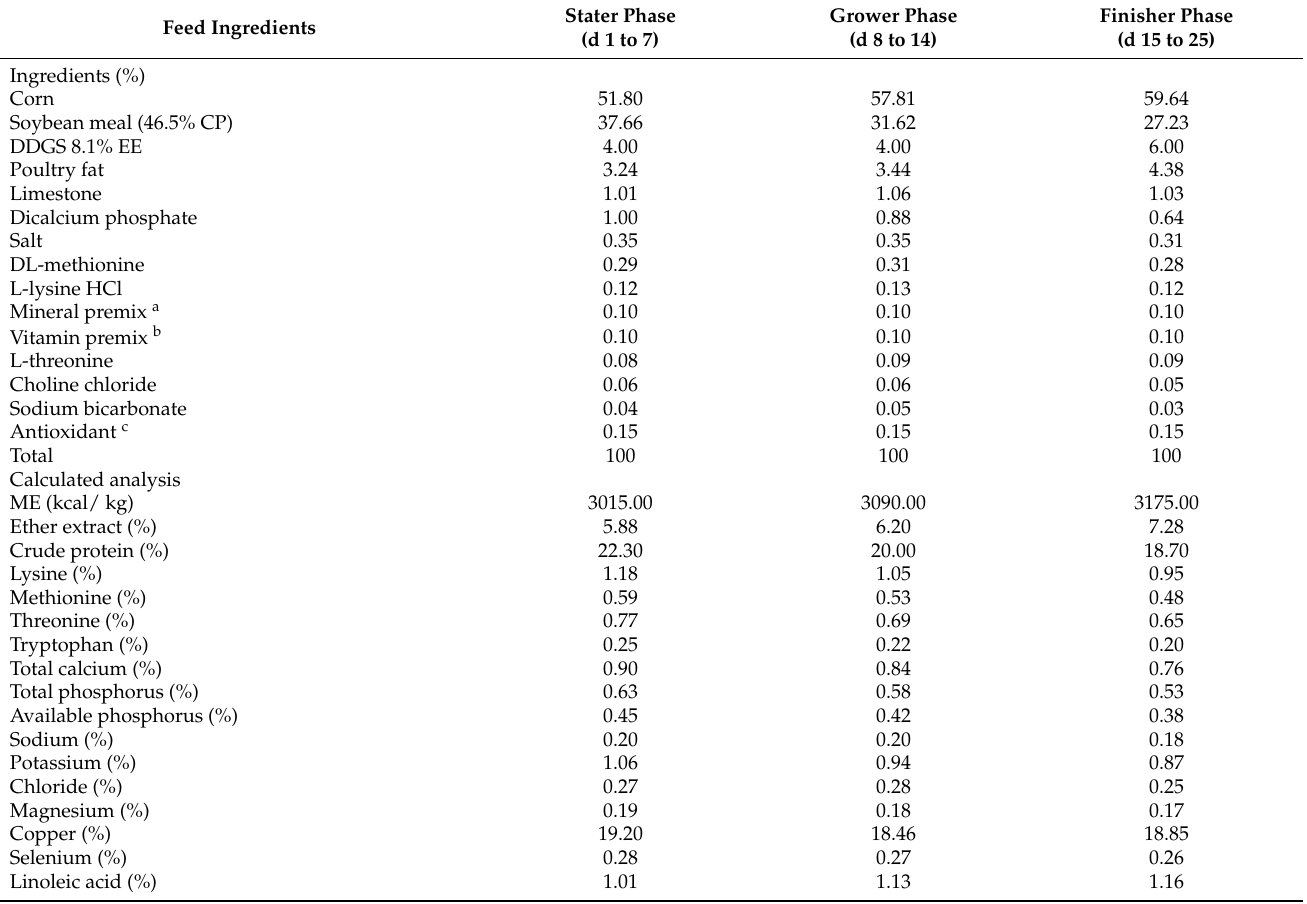
Table 2. Ingredient composition and nutrient content of the corn-soybean diet used on an as-is basis. Feed